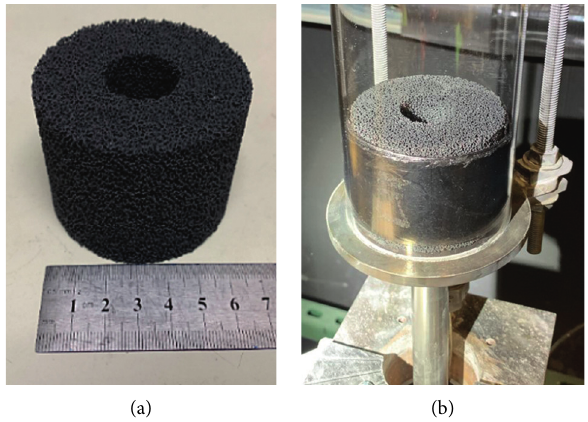
Figure 2: (a) Ring-shaped porous media (b) and combustor installation; dimension in